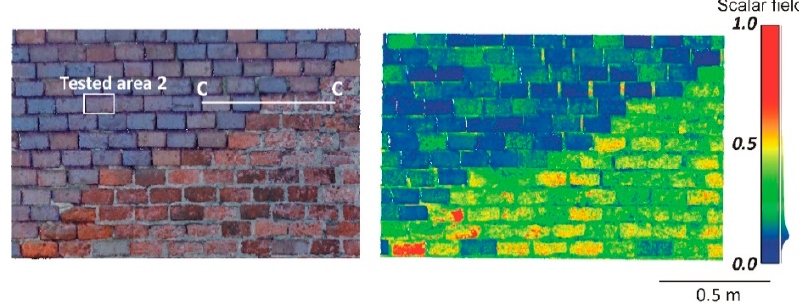
Figure 1. Part of the tobacco factory building—real photo on the left, point cloud on the right.